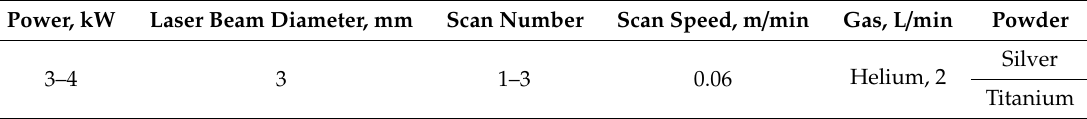
Table 1. Process